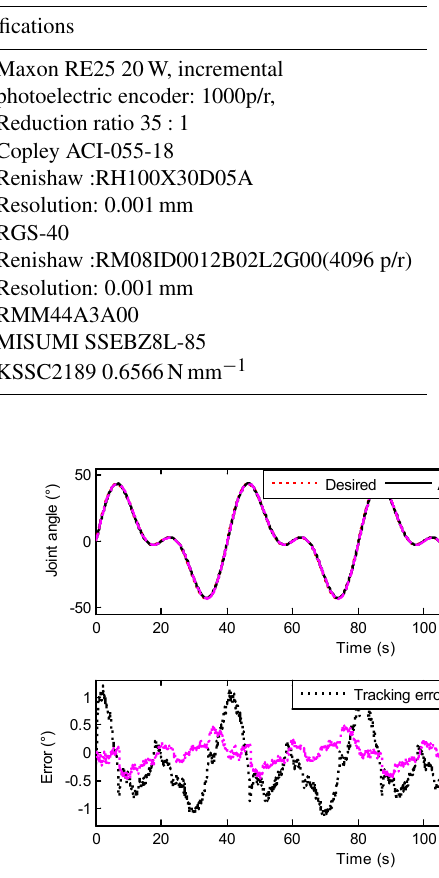
Figure 13. The test results of the robustness of the control system.